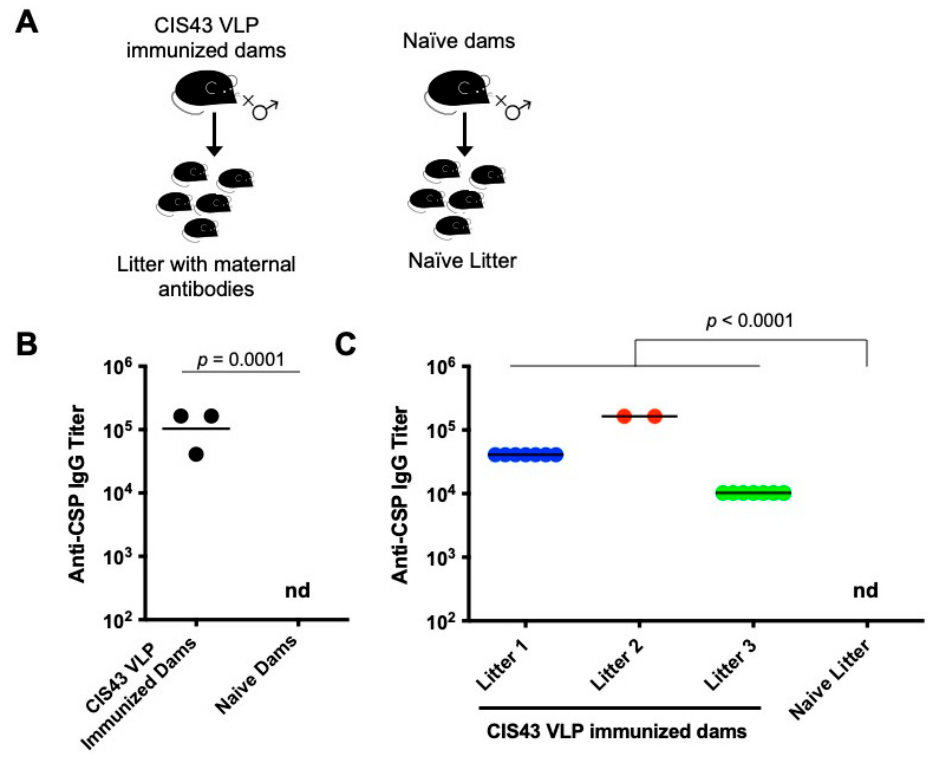
Figure 1. Anti-CSP IgG levels in CIS43 VLP-immunized dams and their pups. ( A ) A schematic of the experimental setup. Female Balb/c mice ( n = 3) were immunized with three doses of 5 µ g of CIS43 VLPs and then mated with a male mouse. A control group of unimmunized mice were also mated with a male mouse. ( B ) IgG titers against CSP in immunized mice were determined by ELISA two weeks following the third dose. A group of three control mice were used as negative controls. ( C ) Immediately following their final immunization, female mice were bred with a naïve Balb/c male. Each of the three dams gave birth to a litter with 7, 2, and 7 pups, respectively. Blood samples were collected from pups at about 2 weeks of age and anti-CSP IgG titers were determined by ELISA. As a negative control, three pups from the litter of a control dam were also tested. Each data point represents an individual mouse and lines denote the geometric mean titer of each group. Colors represent the different litters. If antibody titers were <40, the limit of detection, then the titer is listed as nd (not detected). Data were compared statistically by two-tailed t test using log-transformed values.